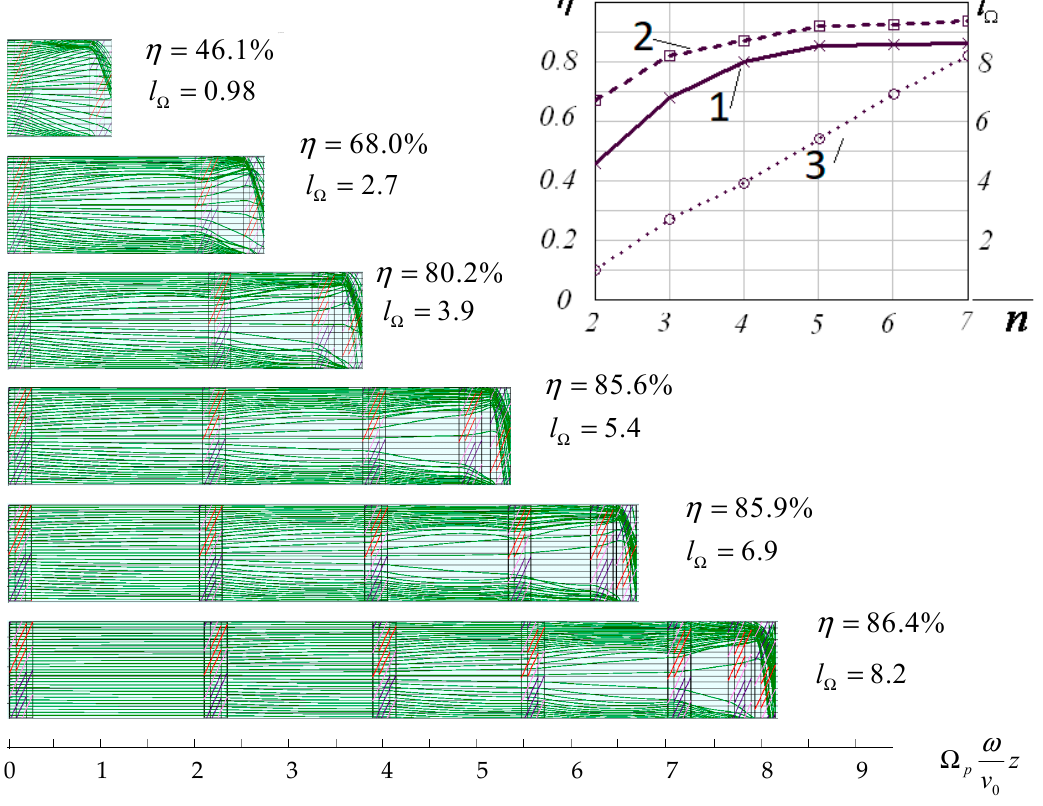
Figure 8. Stage-by-stage optimization of the klystron.